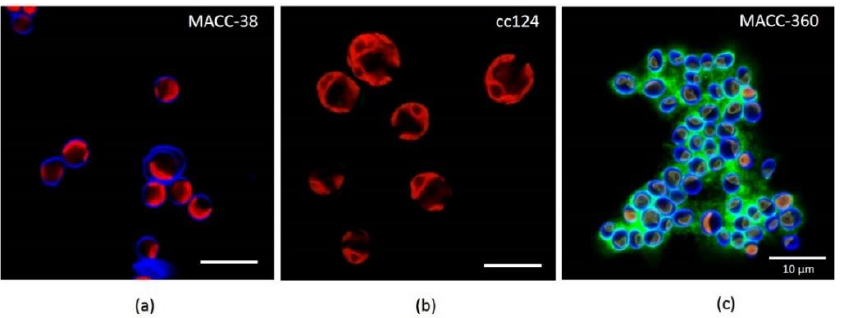
Figure 3. CLSM pictures of live microalgae cells on the 7th day after inoculation; ( a ) Chlorella MACC-38; ( b ) C. reinhardtii cc124; ( c ) Chlorella MACC-360 stained with calcofluor white (CFW) and concanavalin A (Con A). The blue fluorescence is CFW dye, which stains the cell walls, red is the chloroplast autofluorescence of live cells and green fluorescence is Con A dye, which binds to extracellular polysaccharides (EPS).